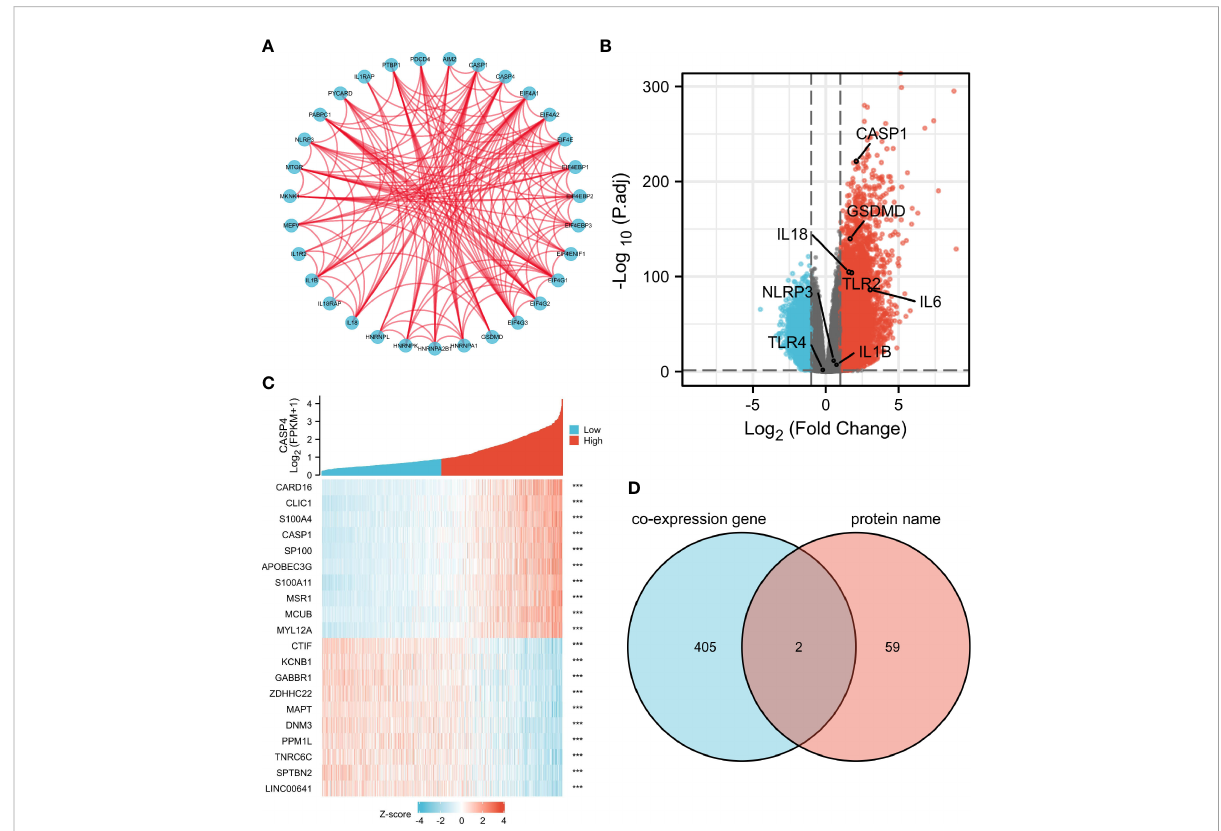
FIGURE 6 Protein – protein interactions (PPI) and functional analysis of CASP4 and its co-expressed genes in gliomas. (A) The PPI analysis of 61 binding proteins is performed using the STRING software. (B) Volcano plot of differentially expressed genes between the high- and low-CASP4- expression groups. (C) Heat map of the top 10 signi fi cantly differentially expressed genes between the high- and low-CASP4-expression groups. (D) Venn diagram of the above-mentioned two groups showing two common members, namely, CASP1 and